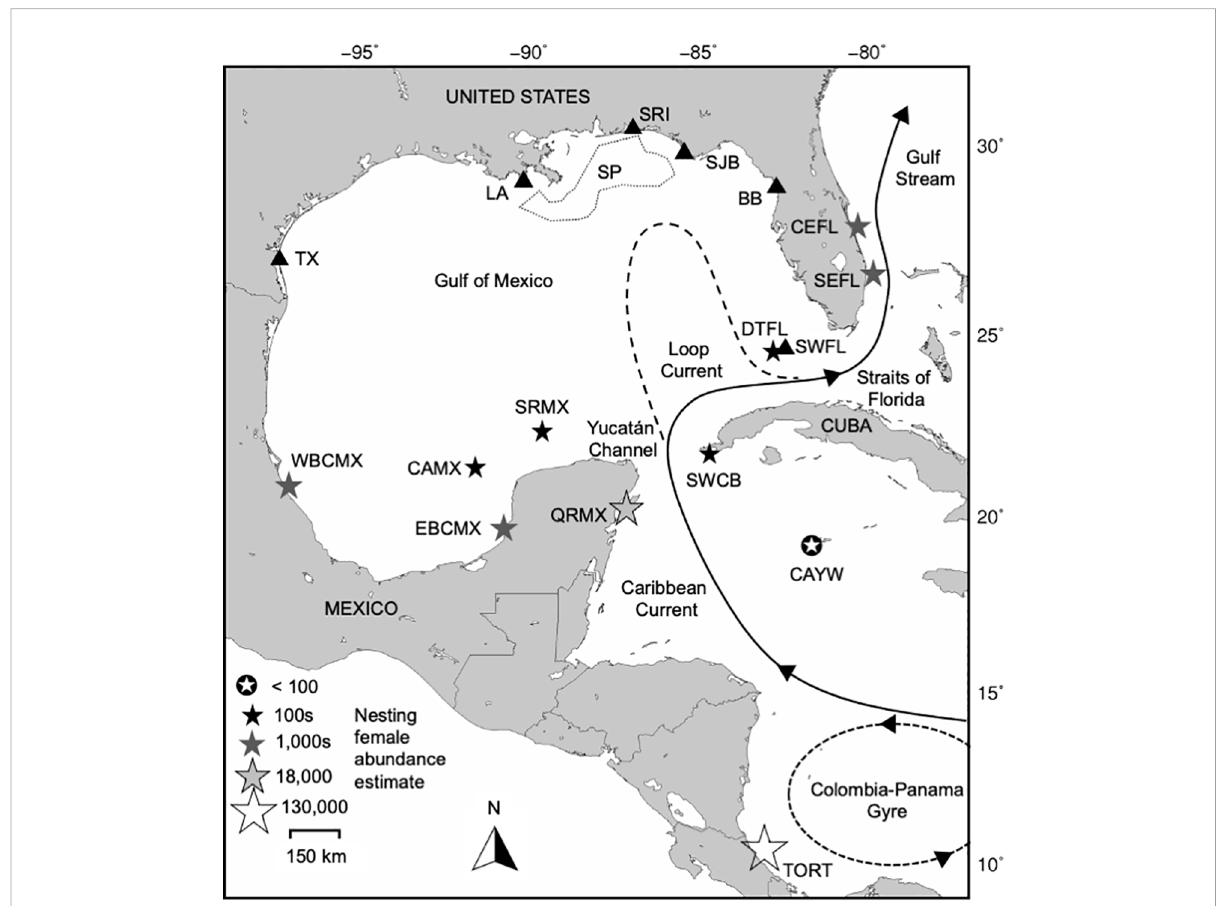
FIGURE 1 Gulf of Mexico neritic juvenile green turtle foraging aggregations (black triangles) and their potential source populations considered in mixed stock analyses (stars). Foraging aggregation abbreviations are: TX, Texas; LA, Louisiana; SRI, Santa Rosa Island, Florida; SP, surface-pelagic, spanning Louisiana to Florida waters indicated by the dotted line; SJB, St. Joseph Bay, Florida; BB, Big Bend region, Florida; SWFL: southwestern Florida (Dry Tortugas and Everglades). Source population abbreviations are: TORT, Tortuguero, Costa Rica; CAYW, Cayman Islands; SWCB, southwestern Cuba; QRMX, Quintana Roo, Mexico; WBCMX, Tamaulipas and Veracruz, Mexico; EBCMX, mainland Campeche and Yucata ́ n, Mexico; CAMX, Cayo Arcas, Mexico; SRMX, Scorpion Reef, Mexico; DTFL, Dry Tortugas, Florida; SEFL, southeastern Florida; CEFL, central eastern Florida. The fl ow of major surface currents in the region is included for